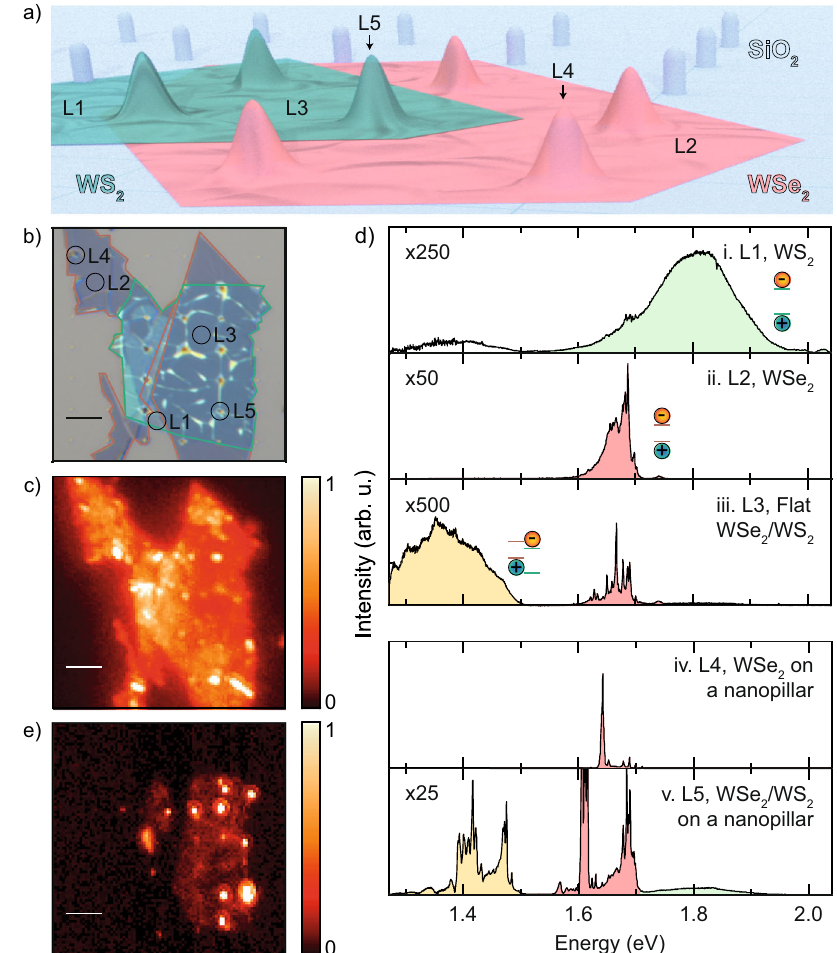
Fig. 1 Optical characterisation of the WS 2 /WSe 2 heterostructure. a Illustration of our devices. The SiO 2 substrate with nanopillars is in blue, the WSe 2 monolayer in red and the WS 2 monolayer on top in green. Representative locations on the device are indicated: location L1 is the WS 2 monolayer, location L2 is the WSe 2 monolayer, location L3 is the fl at WS 2 /WSe 2 heterostructure, location L4 is the WSe 2 monolayer on a nanopillar and location L5 is